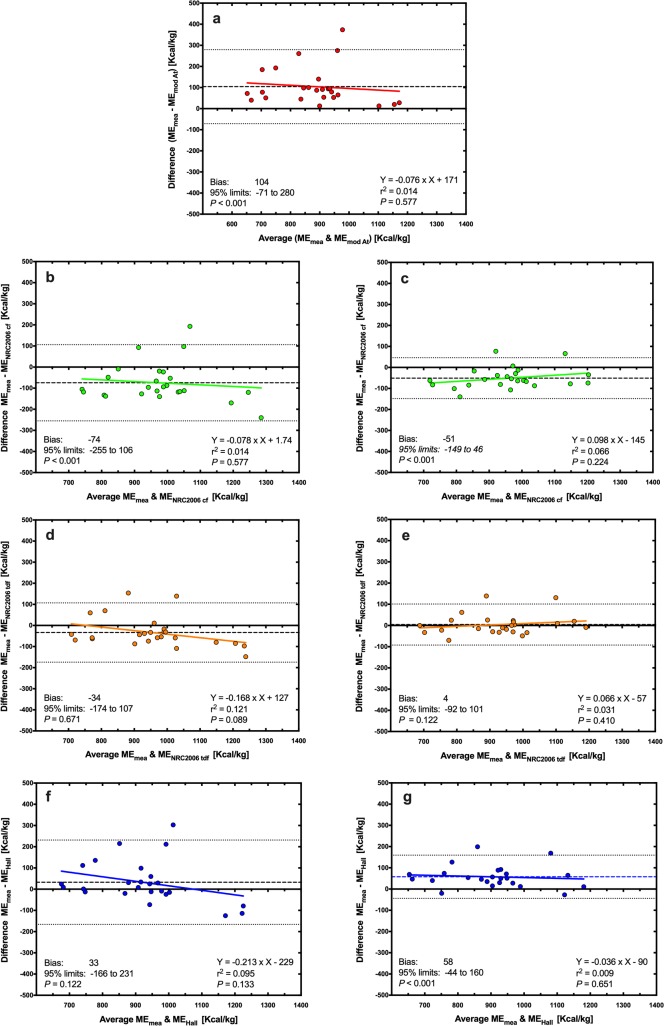
Bland-Altman plot depicting the relationship between measured and predicted metabolisable energy (ME) content in wet feline diets.The y- and x-axes depict the difference between and the average of the measured and predicted ME content of dry canine diets, respectively. The points represent results for individual foods, the dashed back line depicts the average bias, the dotted black lines depict the 95% confidence limits to the agreement, and the solid coloured line represents the trendline from linear regression analysis. Different figures represent predictions made with modified Atwater (red, a), NRC 2006cf (green; b: predicted GE; c: measured GE), NRC 2006tdf (orange; d: predicted GE; e: measured GE), and the Hall equation for cats (blue; f: predicted GE; g: measured GE).